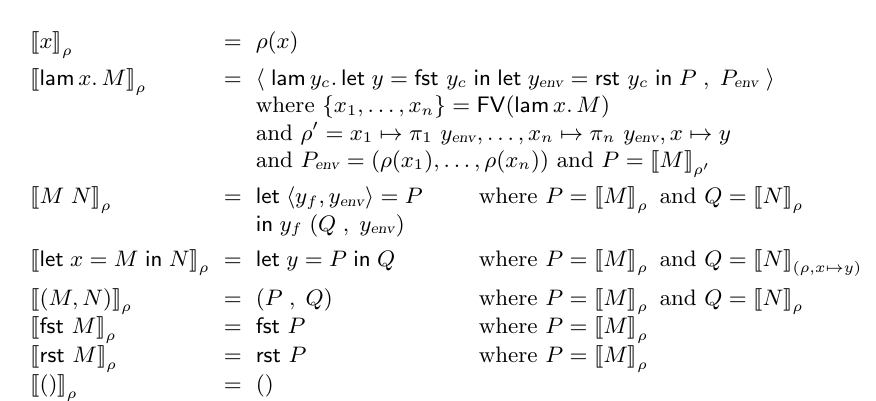
Fig. 10. Closure Conversion